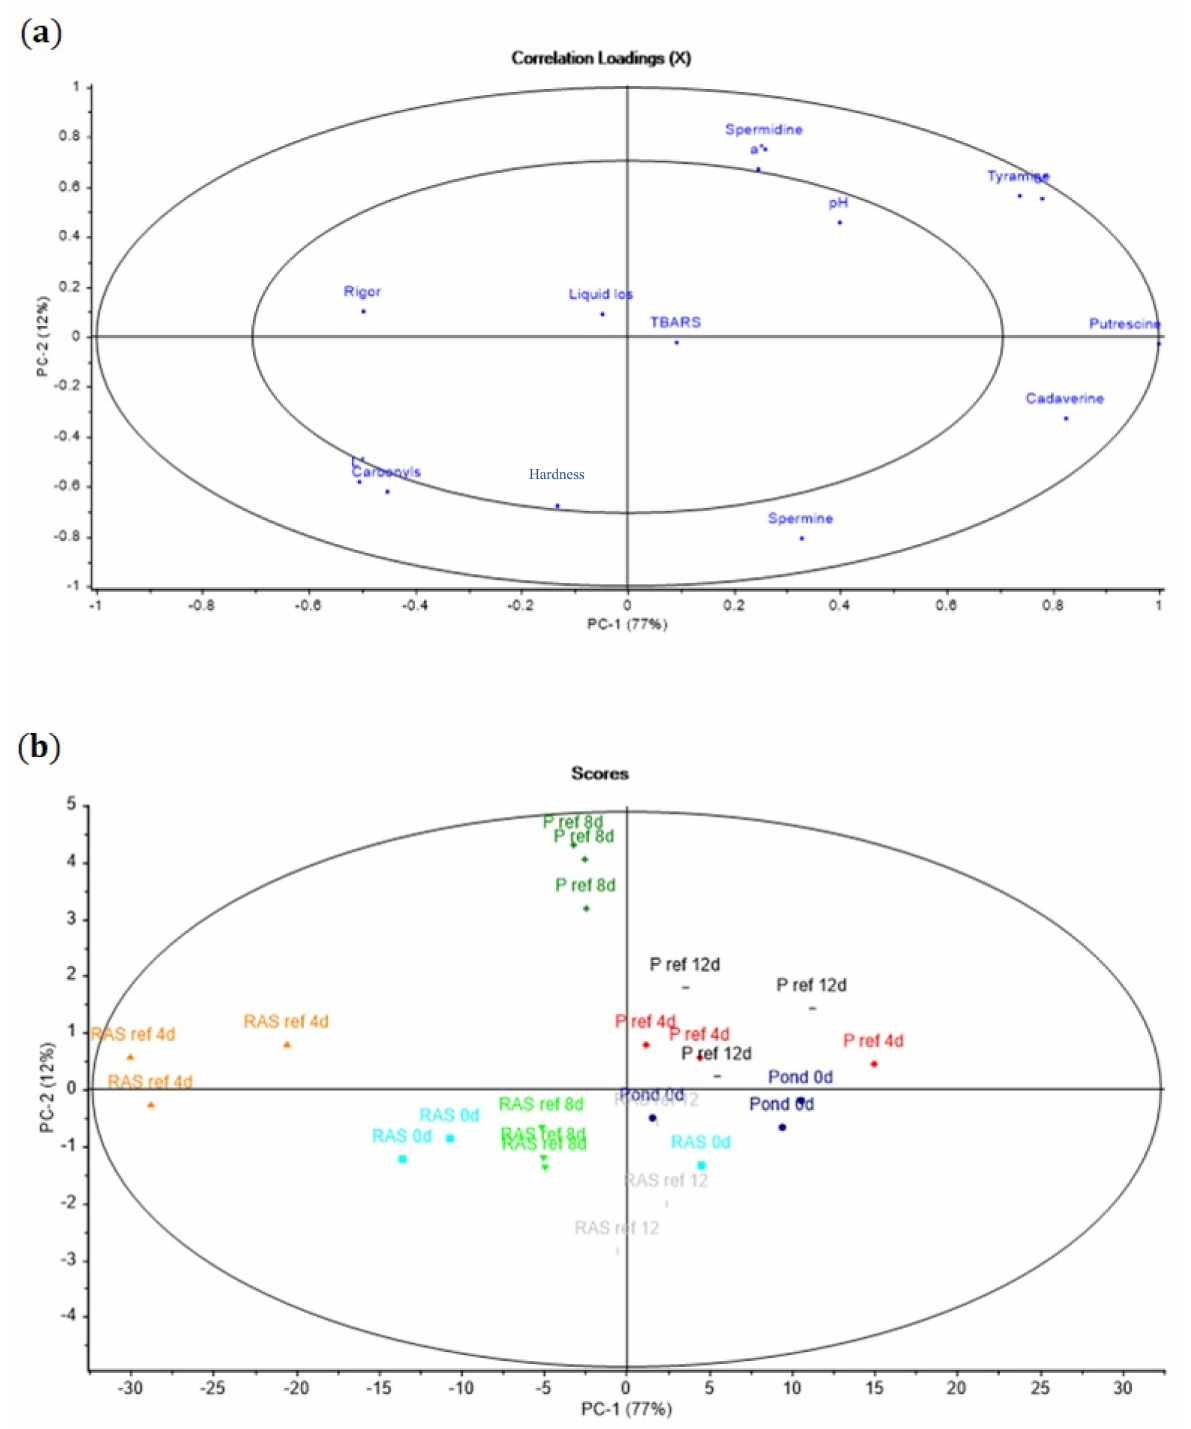
Figure 7. ( a ) PCA plot showing the correlation loadings on PC 1 and PC 2 of the oxidation parameters TBARS and the carbonyls pH, liquid loss, rigor mortis, color, and hardness parameters of RF and PF during refrigerated storage. ( b ) PCA plot showing the correlation loadings on PC 1 and PC 2 between the storage time for each rearing